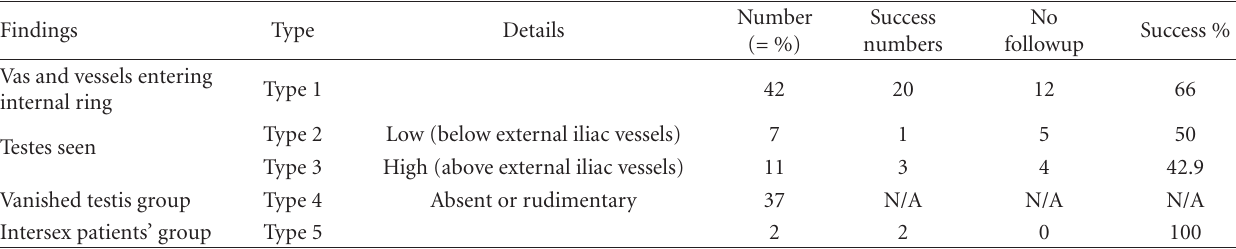
Table 1: Outcomes relative to intraoperative laparoscopic categorization of impalpable testes.